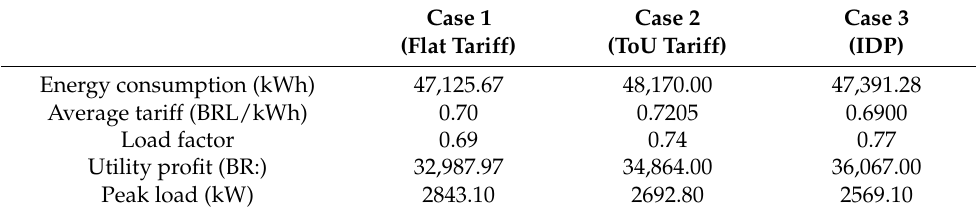
Table 3. Simulations Results.